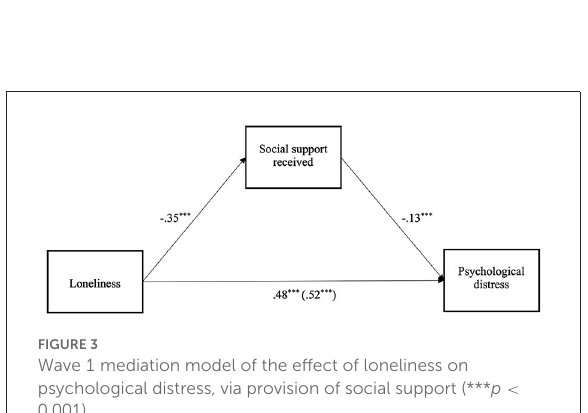
FIGURE3 Wave 1 mediation model of the effect of loneliness on psychological distress, via provision of social support (*** p <